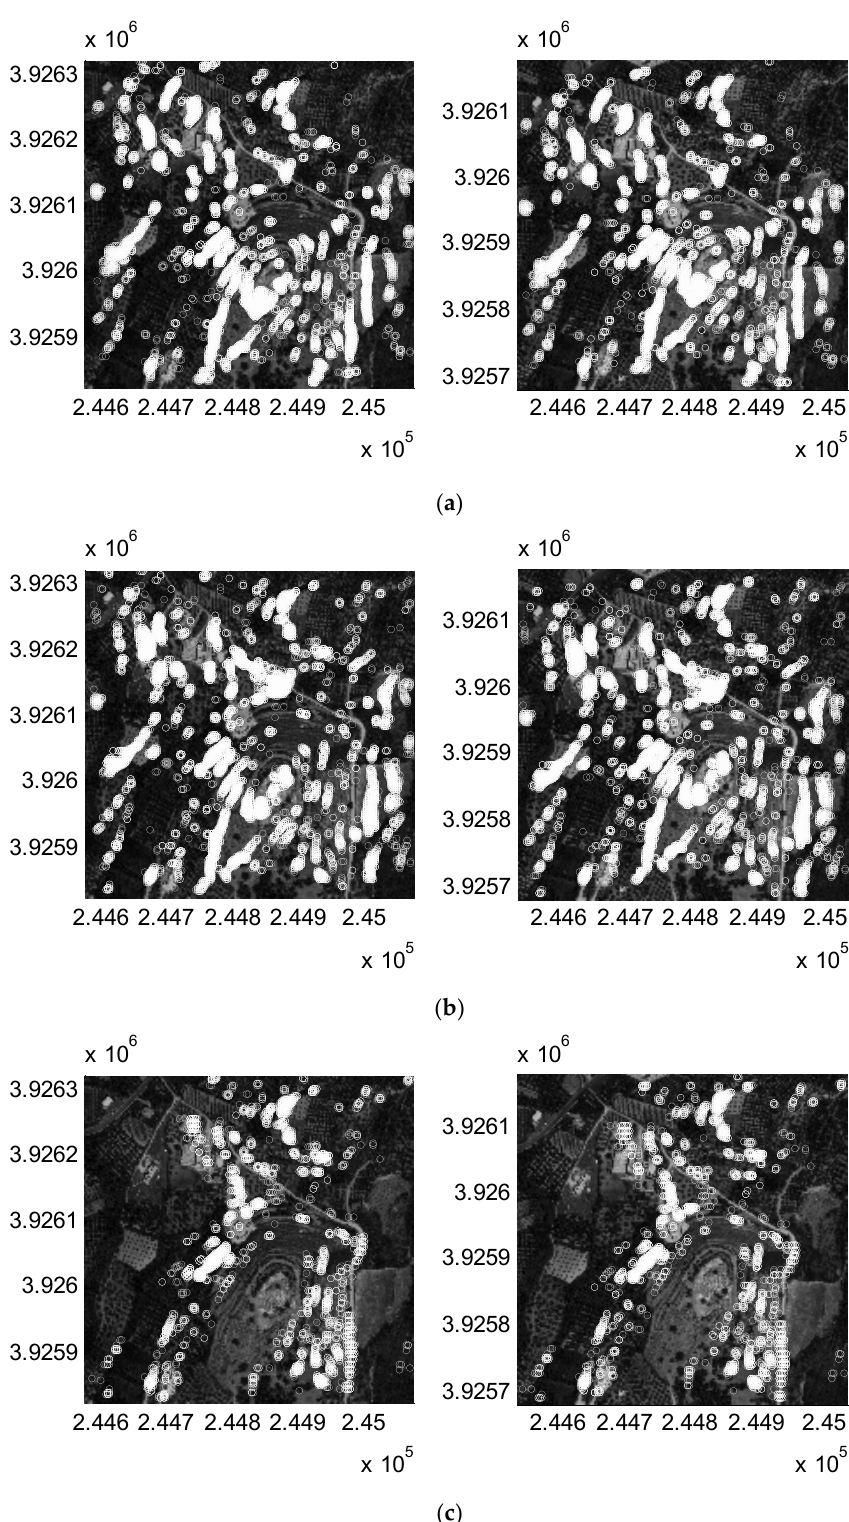
Figure 8. Homologous matches produced by iterative Scale-Invariant Feature Transform (SIFT) on tile sides of ( a ) 250 pixels, ( b ) 130 pixels, and ( c ) − 50 pixels at 70% tile overlap and threshold t = 10 − 6 the red band of stereo pair members (one pear per row). Axes units in m of the Greek National Grid coordinate system.